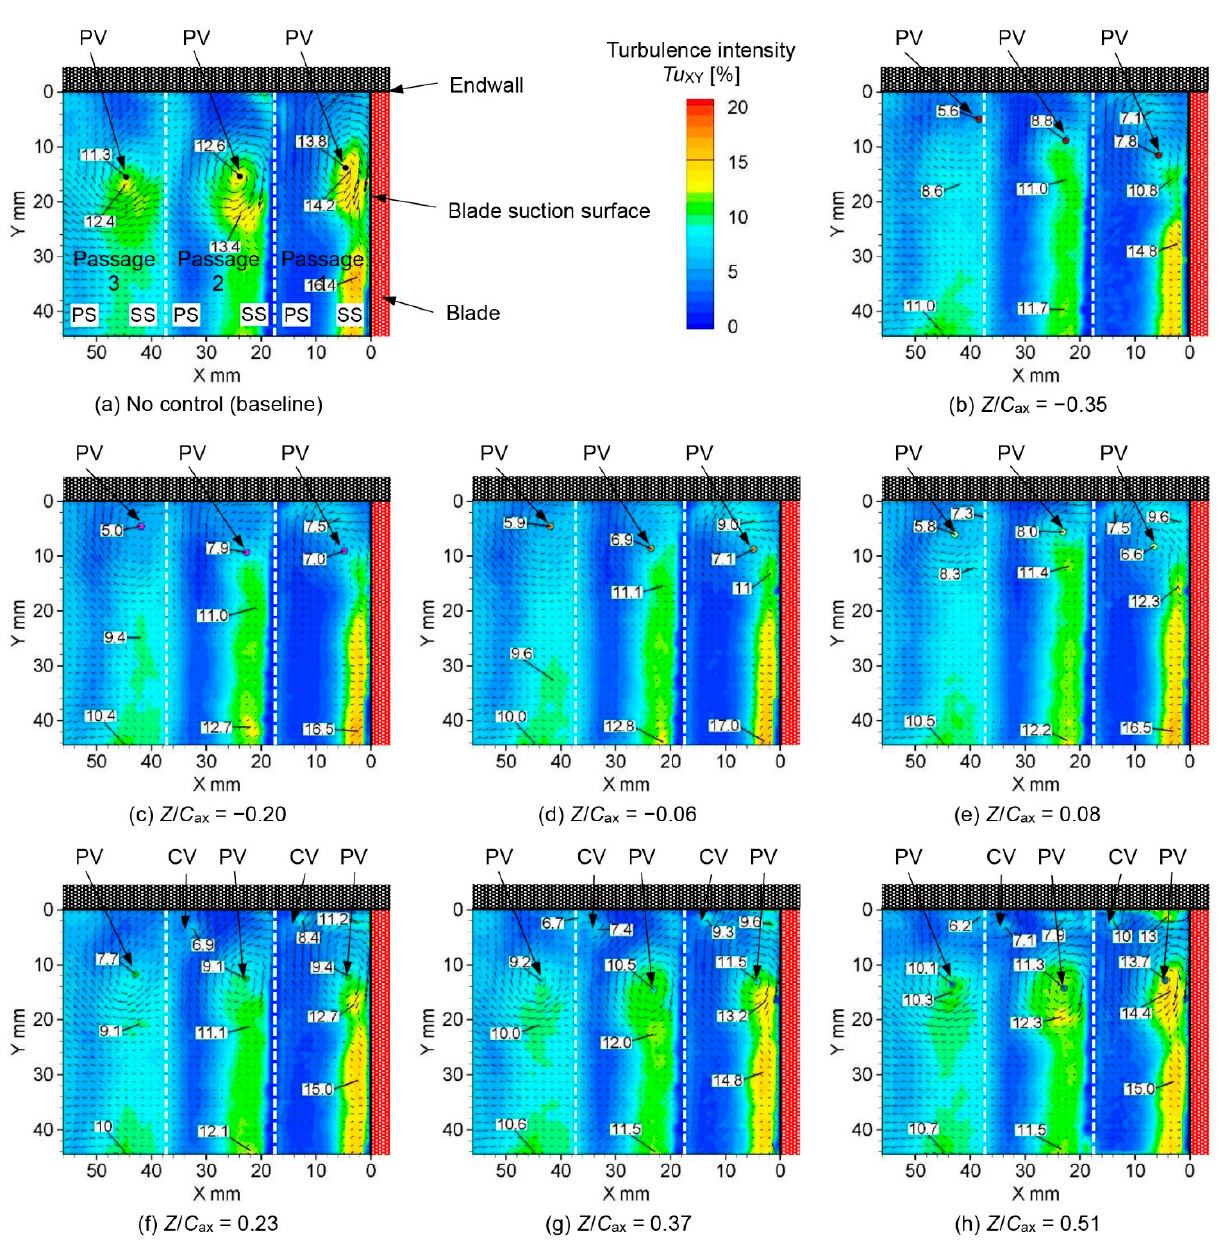
Figure 12. Turbulence intensity distributions of secondary flow at the outlet of the linear turbine cascade at various plasma actuator locations (Re out = 1.8 × 10 4 ). cascade at various plasma actuator locations (Re out = 1.8 × 10 4